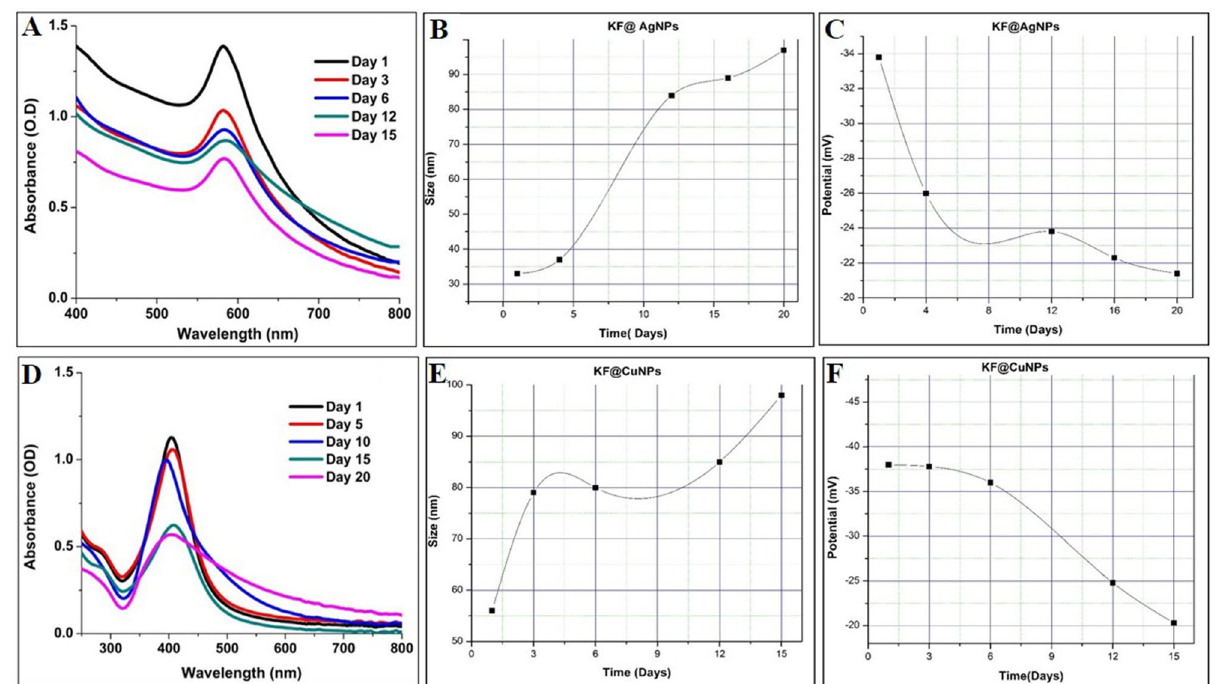
Figure 2. Stability studies on optimized Kaempferitrin-AgNPs/CuNPs ( A – D ) UV-spectrum B -( E ) Zeta size profile ( C – F ) Zeta potential